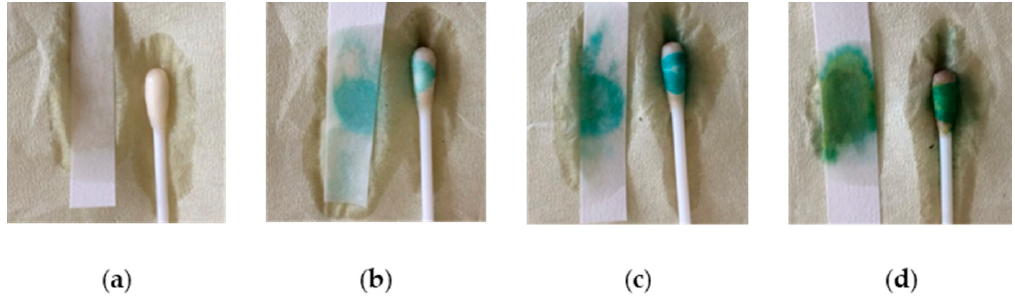
Figure 1. The four panels show the results of the Hemo-Fec ® test of fermented bovine whole blood in rumen fluid for a period of 48 h: ( a ) the negative control (0% blood / rumen fluid), ( b ) 1% blood / rumen fluid mix. ( c ) 5% blood / rumen fluid mix and ( d ) 10% blood / rumen fluid